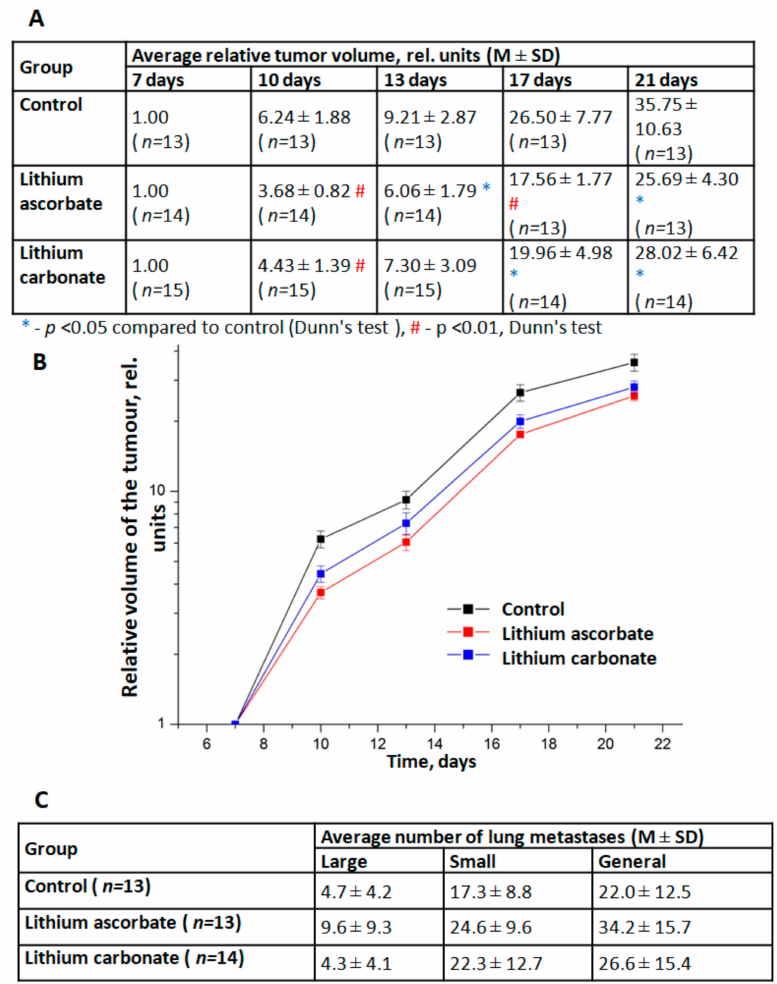
Figure 3. Assessment of the antitumor effects of lithium ascorbate and lithium carbonate. ( A ) Dy- namics of the relative growth of Lewis lung carcinoma in the experimental groups. ( B ) Curves of relative LLC growth. ( C ) Calculation of the number of pulmonary metastases in the experimental groups on the 21st day of LLC